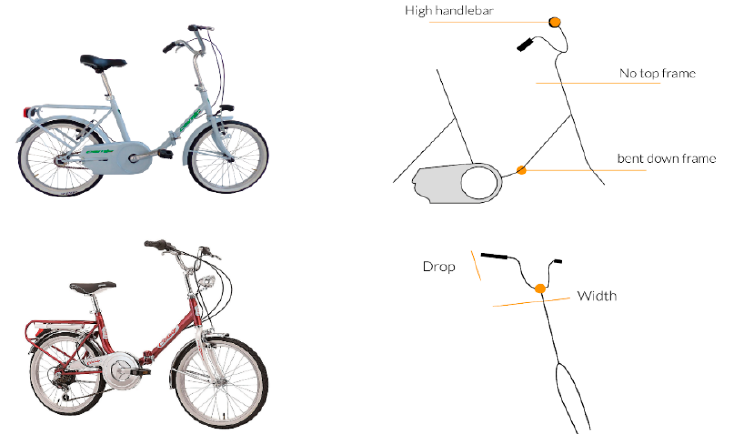
Figure 11. Stylistic references for the retro style—the Atala Piccadilly.